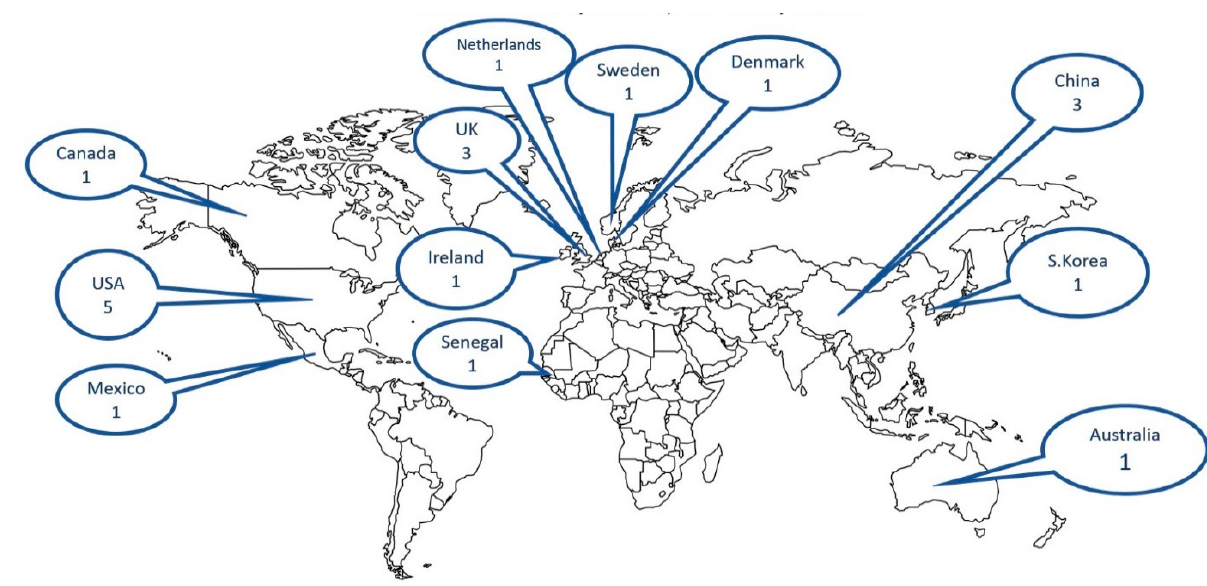
Figure 2. Geographical distribution of the review studies This is a royalty free image, ©Copyright J. Bruce Jones 2019 www.mapsfordesign (accessed on 26 August 2019).